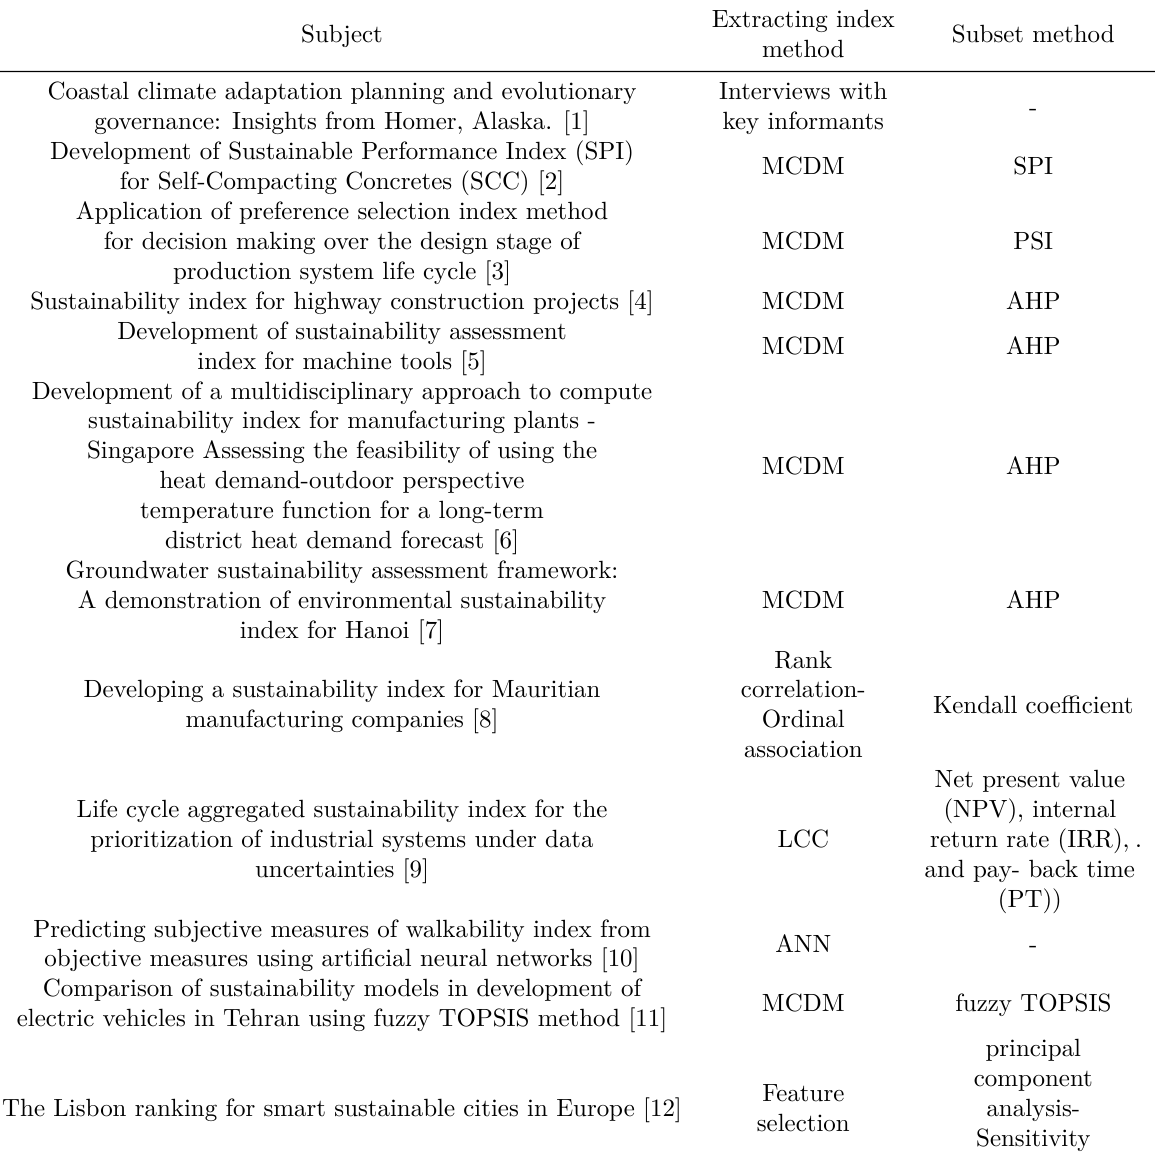
Table 1. Research method and index